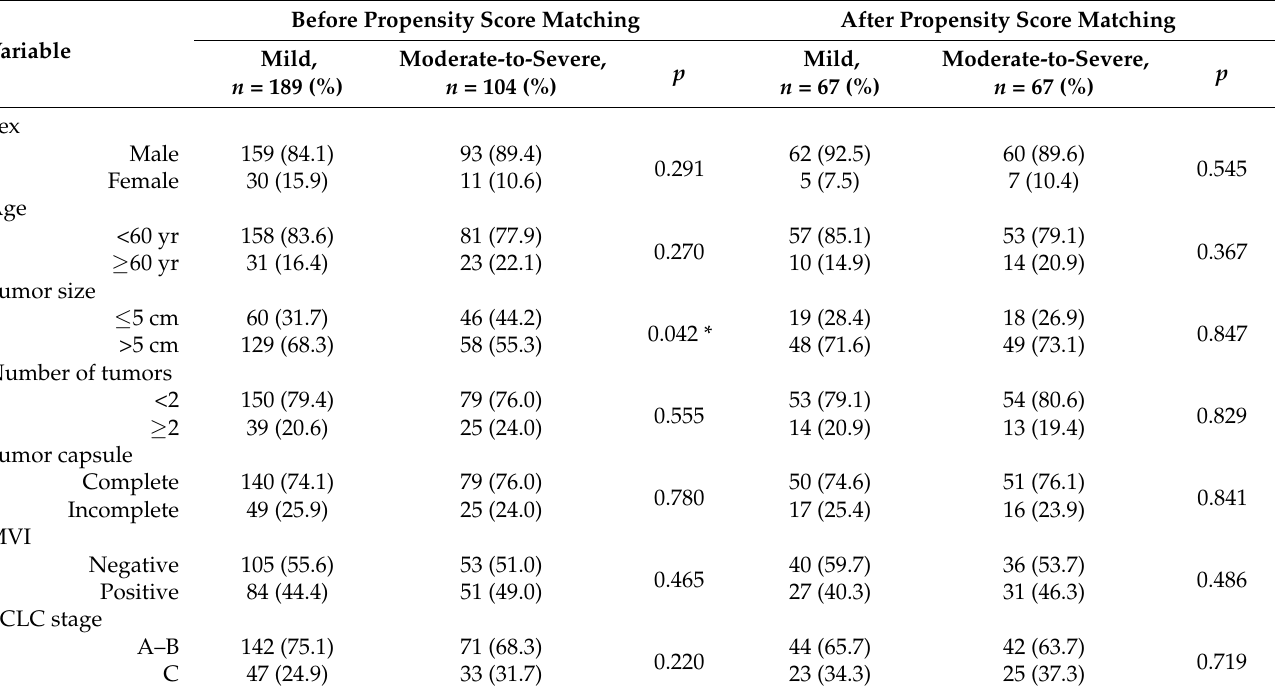
Table 3. Clinicopathological characteristics of patients with non-cirrhotic HBV-associated hepa- tocellular carcinoma who were treated with hepatectomy, stratified based on Scheuer severity of inflammation and